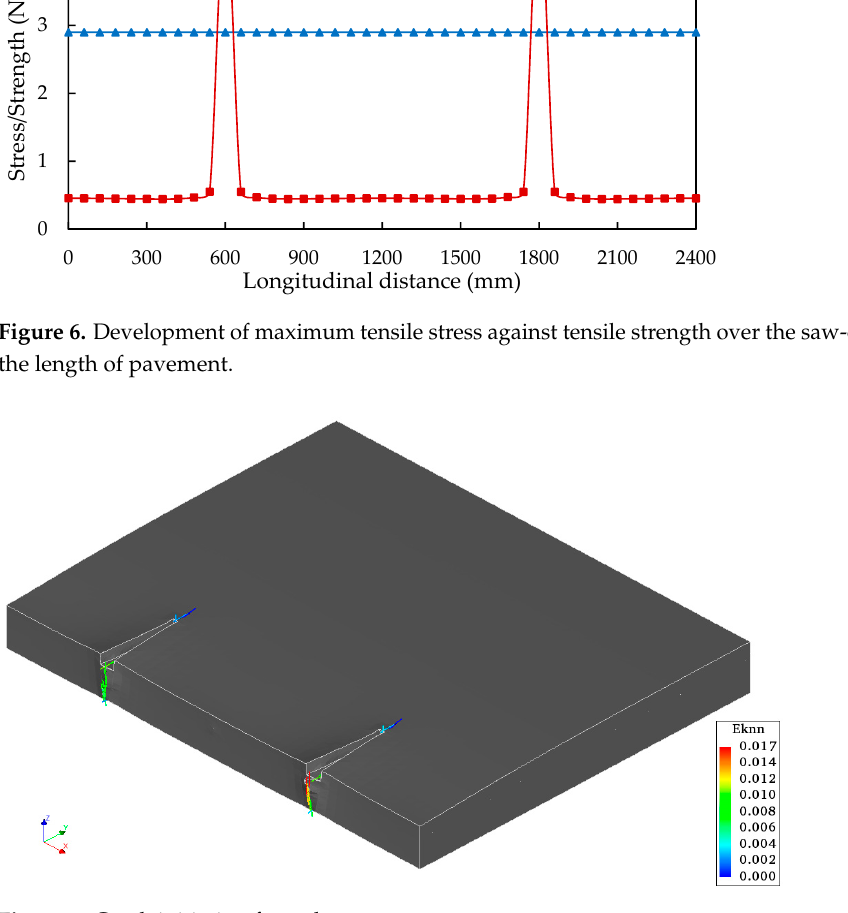
Figure 7. Crack initiation from the saw-cuts.